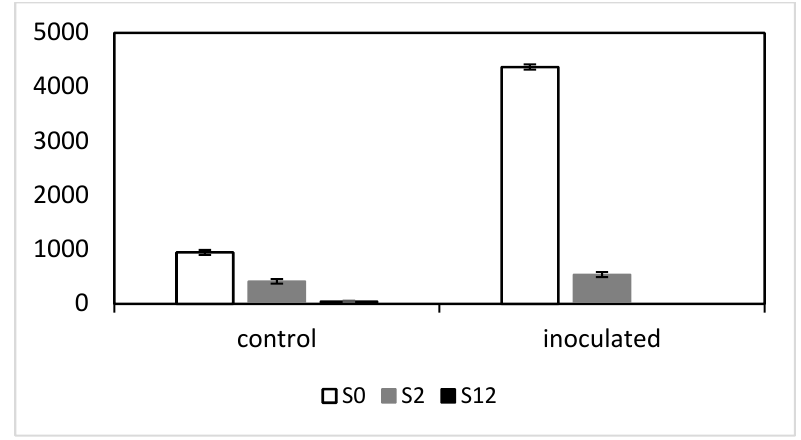
Figure 5. Number of messenger RNA (mRNA) reads mapped to Mlo exons 6 to 12 ( Y -axis) for Baudin NILs containing mlo-11 ( cnv2 ) (S2), mlo-11 (S12), and wild-type Mlo (S0). Suppressed expression for exons 6 to 12 (not present in the mlo-11 tandem repeats) in S12 is shown, with intermediate suppression in S2, consistent with the epigenetic changes shown in Figure 4. Read counts are averaged across three replicates. The Y -axis shows the number of mRNA reads mapped.